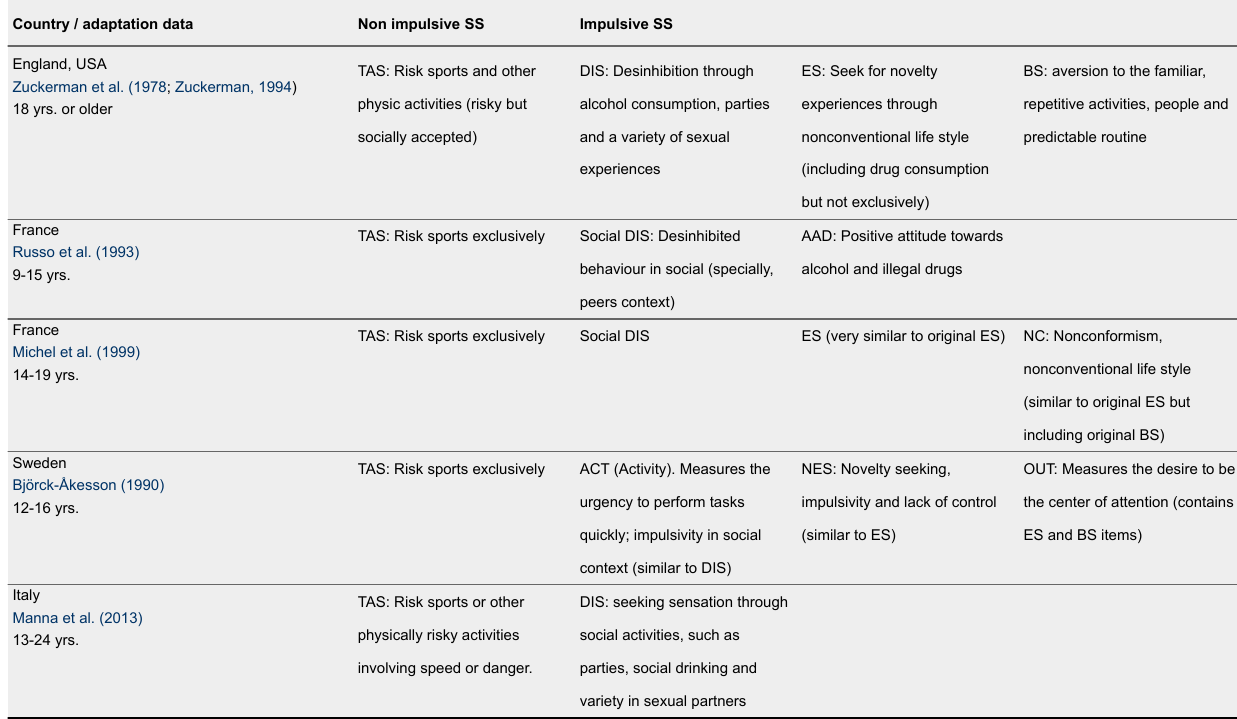
Country / adaptation